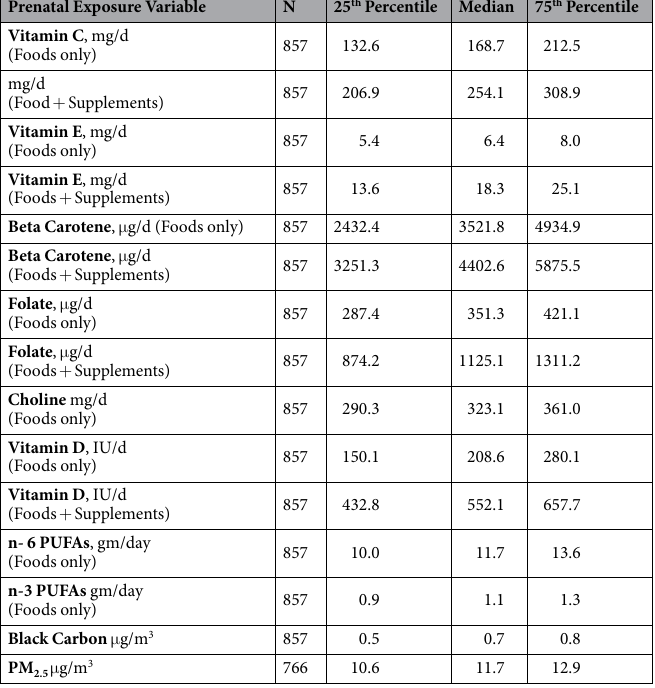
Children of other race/ethnicity tended to have higher FeNO and IgE, and there was a suggestion of an effect for higher IgE in black children. Differences between racial groups overall were marginally statistically significant (ANOVA p values = 0.1 for group comparisons). Participants born in winter or spring tended to have higher FeNO, but season of birth was not associated with total IgE levels. Maternal history of hay fever was related to a higher offspring total serum IgE concentration in adolescence (p = 0.006). There was no evidence for associations between report of smoking in pregnancy or maternal BMI and either FeNO or total serum IgE in adolescence. For BKMR analyses, posterior inclusion probabilities were calculated for exposure groups in models for each outcome. In models for FeNO, the largest group of nutrients (Vitamin D, Vitamin C, Folate, n − 3 and n − 6 pol- yunsaturated fatty acids (PUFAs)) was consistently ranked higher than air pollutant exposures, with the second nutrient grouping (Vitamin E and β -carotene) ranked last. (Supplemental Table 2) In models for IgE, air pollutant exposures had much higher posterior inclusion probabilities than either of the individual nutrient groups, which showed similar posterior inclusion probabilities to one another. (Supplemental Table 3). For models of FeNO, estimated dose response curves for individual exposures are shown in Fig. 1, and point estimates for percent increase in FeNO z score, with an increase in exposure from the 25 th to 75 th percentile, (with all other exposures are fixed at the median) are shown in Table 3. Maternal prenatal n − 3 polyunsaturated fatty acids and folate from food sources were associated with reduced early teen FeNO levels ( − 9.21% (95% CI − 16.81% to − 0.92%) for n-3s and − 3.86%, (95% CI − 8.33% to 0.83%) for folate. In models with IgE as the out- come, point estimates for these two nutrients and were similar in magnitude and direction (Table 3). Prenatal vitamin D intake from foods showed a trend toward decreased FeNO measures in adolescence (Table 3). Overall, the strongest association observed was for black carbon (BC) exposure and total IgE level (15.25% increase in total IgE was associated with an interquartile range increase in log BC exposure). In models for the FeNO out- come, the point estimate for BC was 7.39% (95% CI − 1.35 to 16.91%). We also considered nutrient exposures as combined intakes from food and supplements, if supplement intakes for a given nutrient were available in our data (Table 4). Vitamin D intake (food plus supplements) showed a strong inverse association with FeNO ( − 16.15%, 95% CI: − 20.38 to − 2.88%). The shape of the estimated dose-response curve was not linear (Fig. 2), with a relatively flat dose-response at lower vitamin D levels, and a decreasing linear slope from moderate to high Vitamin D levels. In contrast, there was no clear relationship between Vitamin D intake from foods plus supplements and total IgE level (Table 4, Fig. 3). The point estimate for prenatal vitamin E intake from food and supplements combined was 6.94% (95% CI − 2.36 to 12.24%) for the FeNO outcome (Table 4), which was much larger than the vitamin E estimate from diet alone (Table 3). No association was observed for Vitamin E and total IgE levels. In addition to modeling exposure to BC as an air pollutant, we also considered exposure to PM 2.5 (Table 4, Fig. 2). PM of another exposure showed an interaction between PM 2.5 and Vitamin E intake from foods plus supplements.